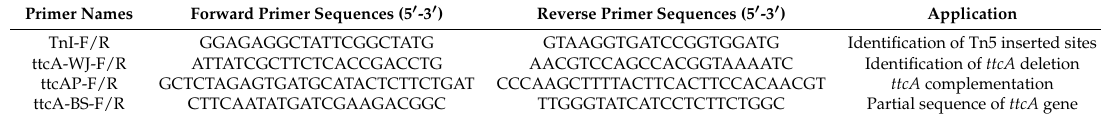
Table 2. List of primers used for ttcA gene knockout and complementation.